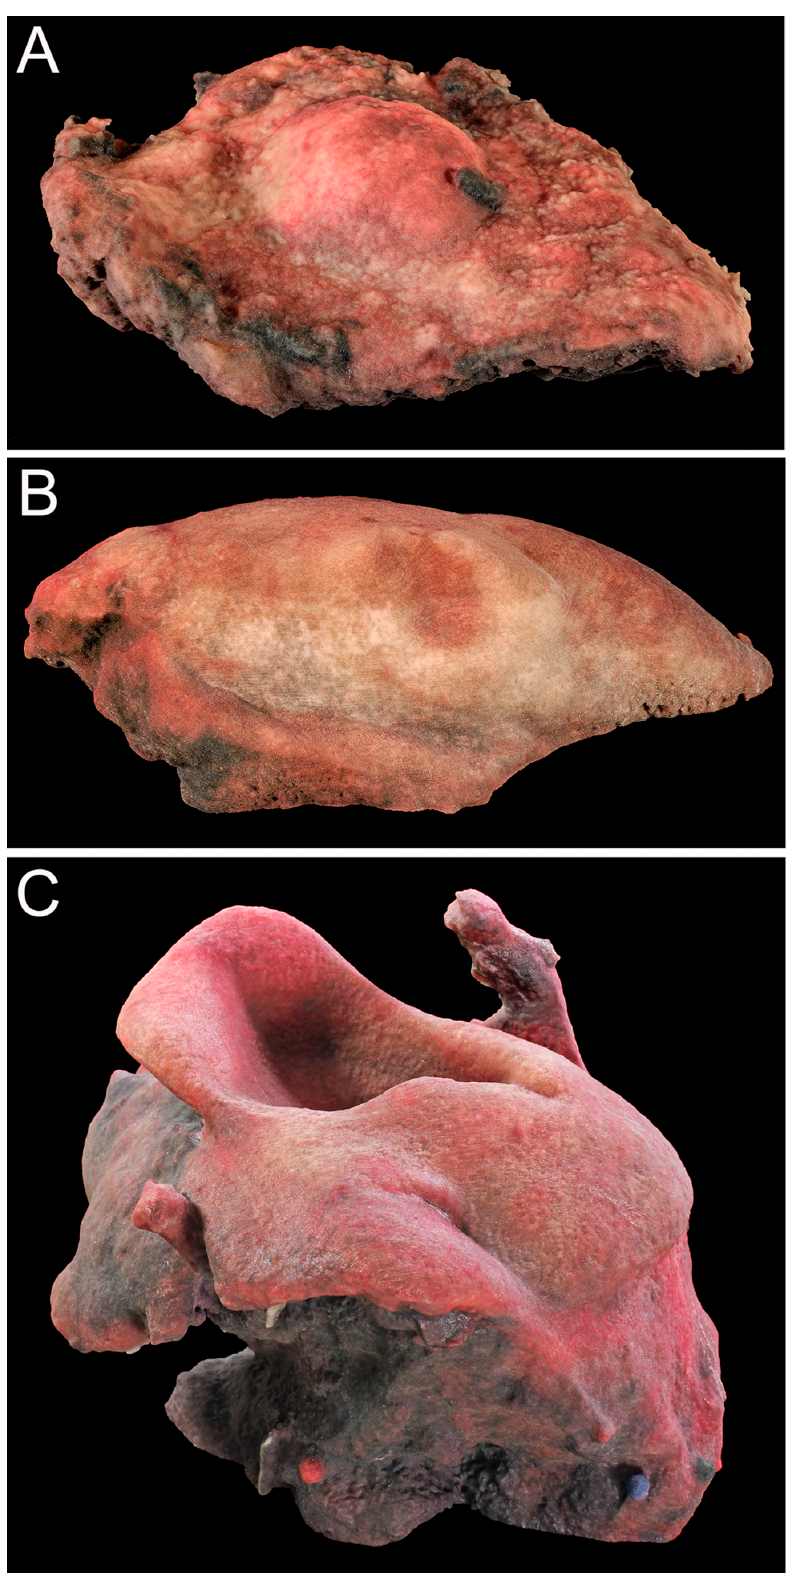
Figure 8. Physical 3D models of Case 1 ( A ), Case 2 ( B ), and Case 3 ( C ) printed via binder jetting.